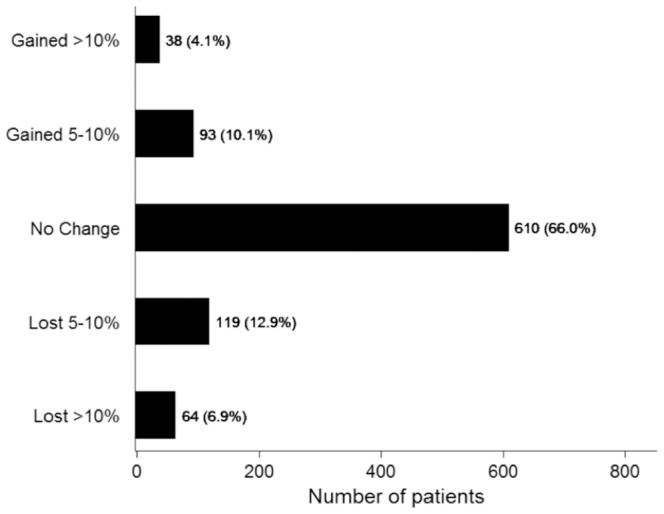
Percent change in body weight at the end of the study period relative to the initial weight.Patients with final body weight within 5% of their initial weight were included in the “No change” group. N = 924 for the entire cohort.